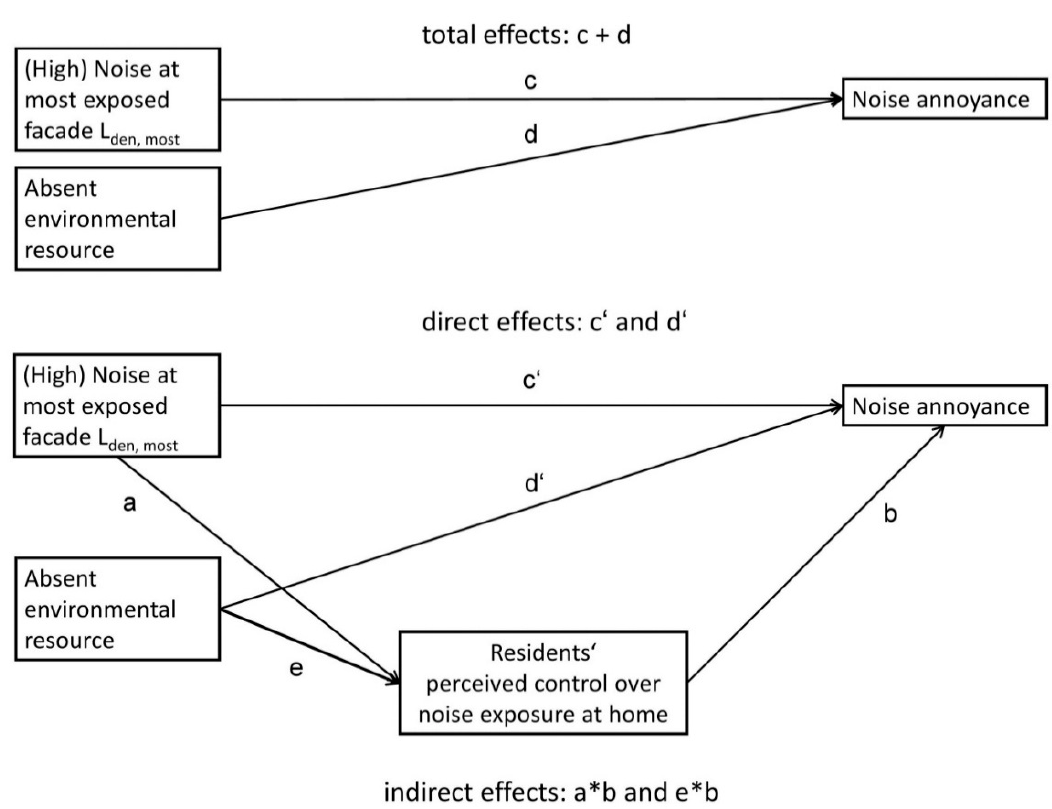
Figure 1. Associations under study for the first objective. Shown are potential total, direct, and indirect effects we aimed to quantify.